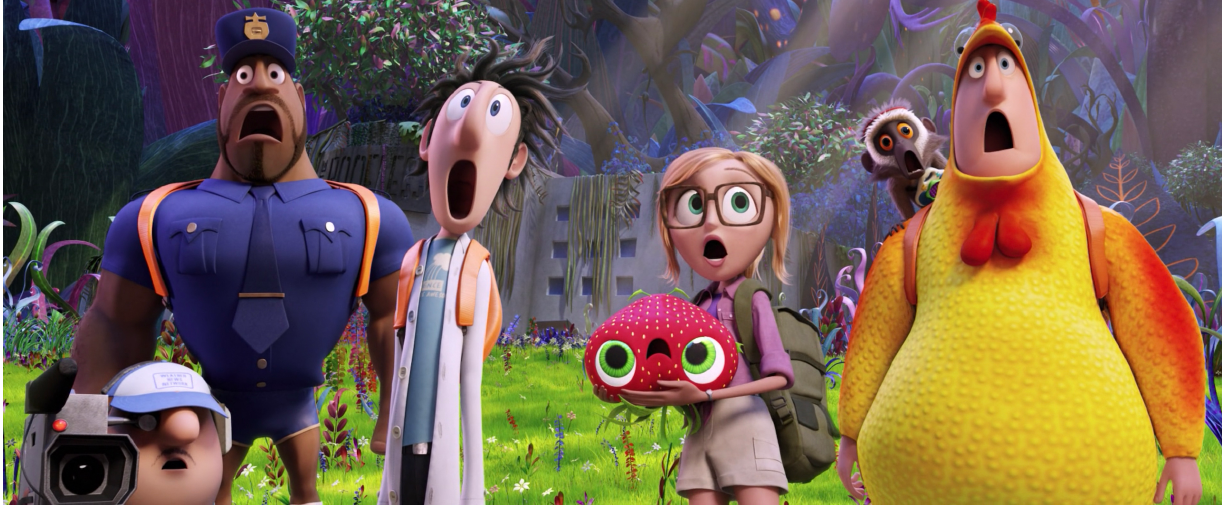
Figure 8: Flint and the gang gasp upon witnessing the foodimals’ ecosystem ( Cloudy 2